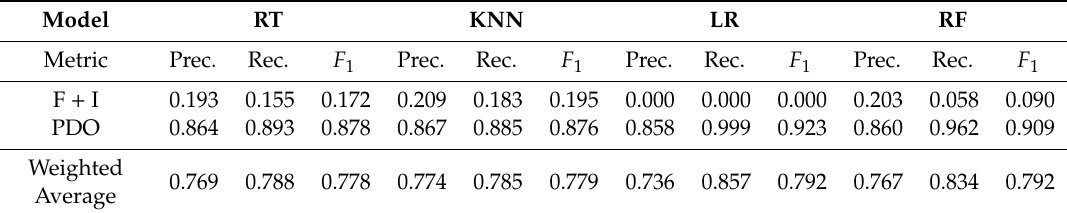
Table 4. Precision, recall, and F 1 score of the classifiers with the imbalanced training set.